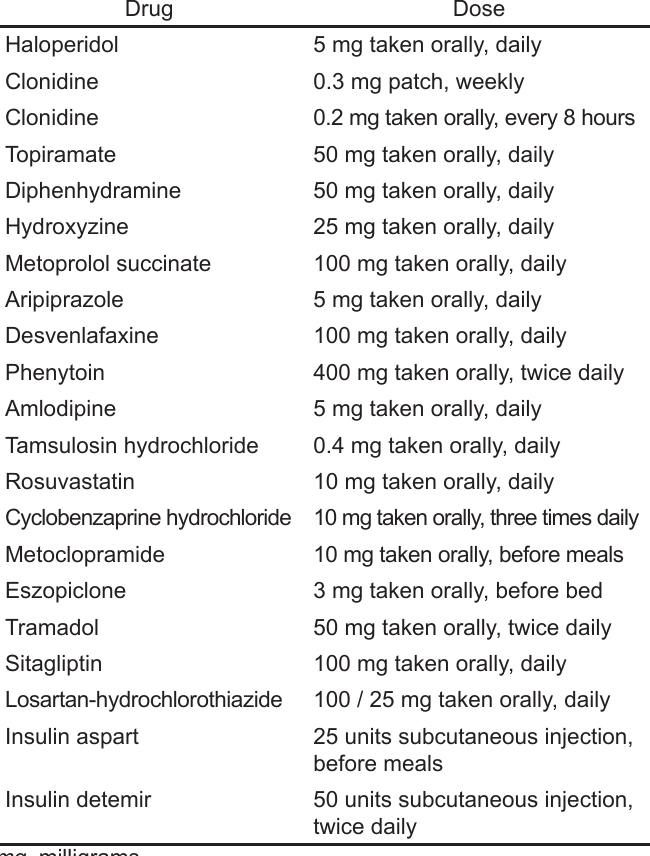
Table 3. Patient one outpatient medications prior to neuroleptic malignant syndrome presentation.